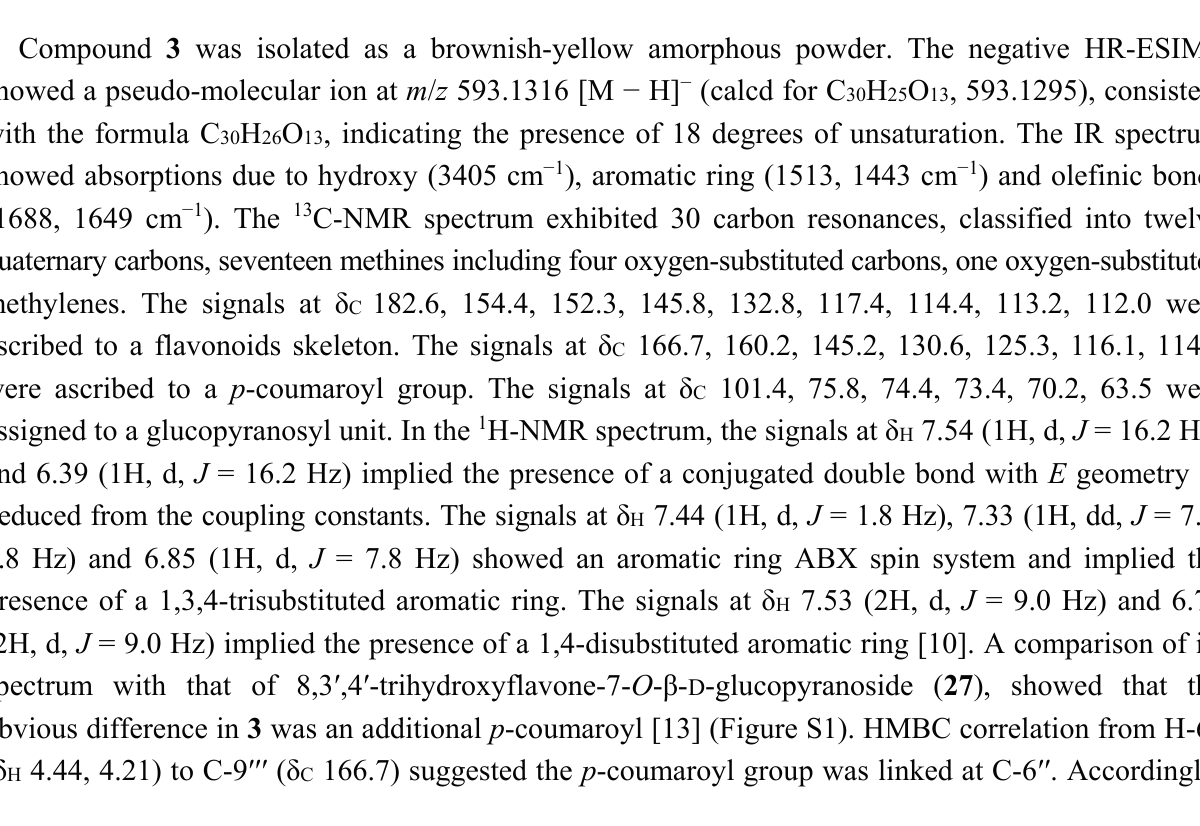
Figure 2. Key 1 H- 1 H COSY and HMBC (H → C) correlations of compound 2